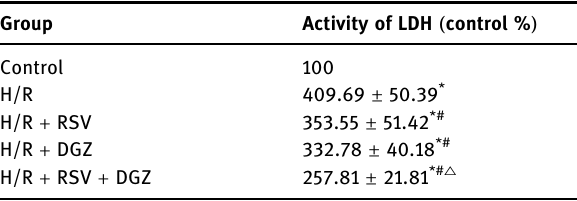
with the H/R group; △ p < 0.01, compared with the H/R + RSV or H/R